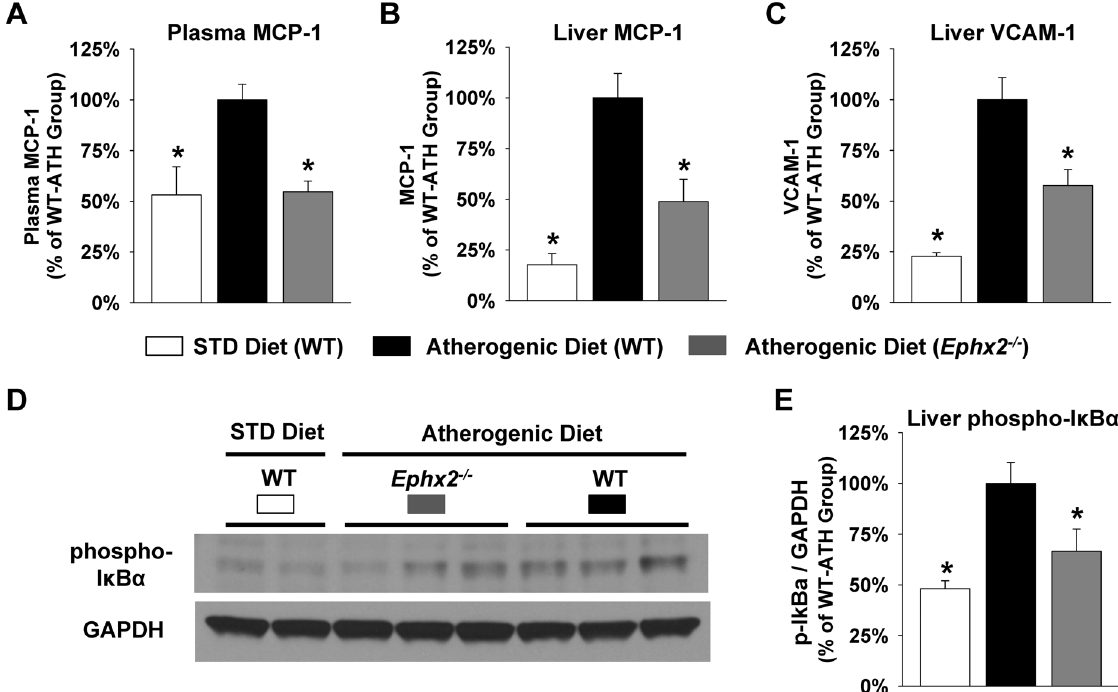
Figure 6. Genetic disruption of sEH attenuates atherogenic diet-induced hepatic expression of inflammatory biomarkers. The atherogenic diet evoked induction of (A) plasma MCP-1, (B) liver MCP-1, and (C) liver VCAM-1 protein levels was significantly attenuated in Ephx2 2 / 2 mice (WT STD diet: n=15–16, WT atherogenic diet: n=37–40, Ephx2 2 / 2 atherogenic diet: n=22–24). (D) A representative immunoblot characterizing protein expression of phosphorylated I k B- a and GAPDH in liver lysates is provided. (E) Densitometry analysis demonstrated that the atherogenic diet- induced increase in phosphorylated I k B- a expression, normalized to GAPDH, was attenuated in Ephx2 2 / 2 mice (n=4–6 per group). Data are expressed relative to the WT atherogenic diet group. *P , 0.05 vs. WT atherogenic diet